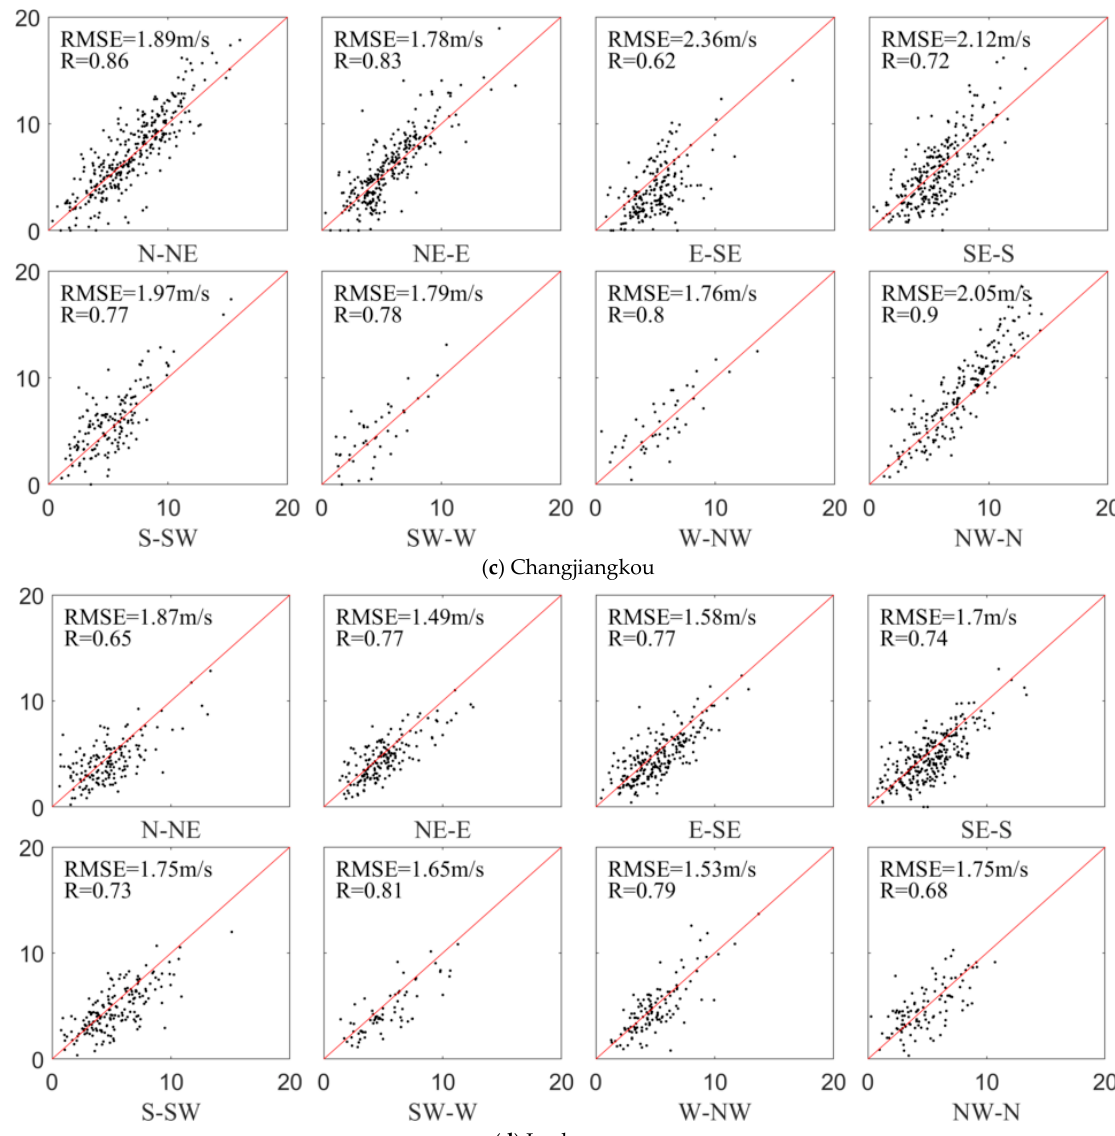
Figure 4. Correlation of measured and ERA-interim wind speed with different directions at different stations. ( a ) Gaoqiao, ( b ) Jinshan, ( c ) Changjiangkou, and ( d ) Luchaogang (the horizontal axis is for the ERA-interim wind speed, the vertical axis is for the measured wind speed, and the unit is m/s). Previous research has shown that reanalysis data underestimate the intensity of tropical cyclones. However, the results of this research show a different finding. The wind speed obtained from the ERA-interim data does not show the underestimation of the actual wind speed for all the stations. Figure 5 shows the error of the reanalysis wind data compared to the observation at stations in the Yangtze Estuary in 2014. Only at Gaoqiao station was the reanalysis wind speed lower than the measured wind speed. The MEs of Gaoqiao station are between 0.12 and 0.27 m/s, and the RMSEs are between 1.02 and 3.33 m/s. The reason for this could be the location of the Gaoqiao station, which is located inside the Yangtze Estuary. The reanalysis wind magnifies the influence of the land underlying surface during data assimilation. The main channel of the estuary is in the NW–SE direction, resulting in the underestimation of reanalysis data in the direction from E to